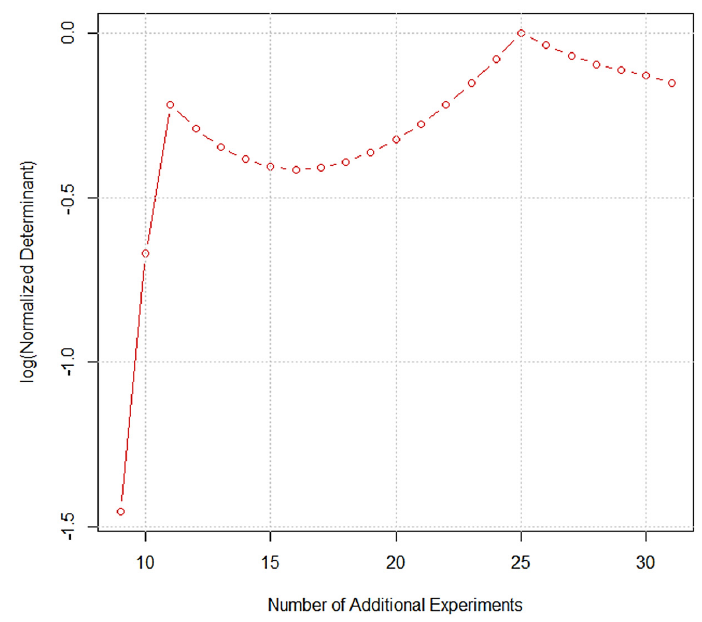
Figure 1. Log(M) as a function of the number of experiments.